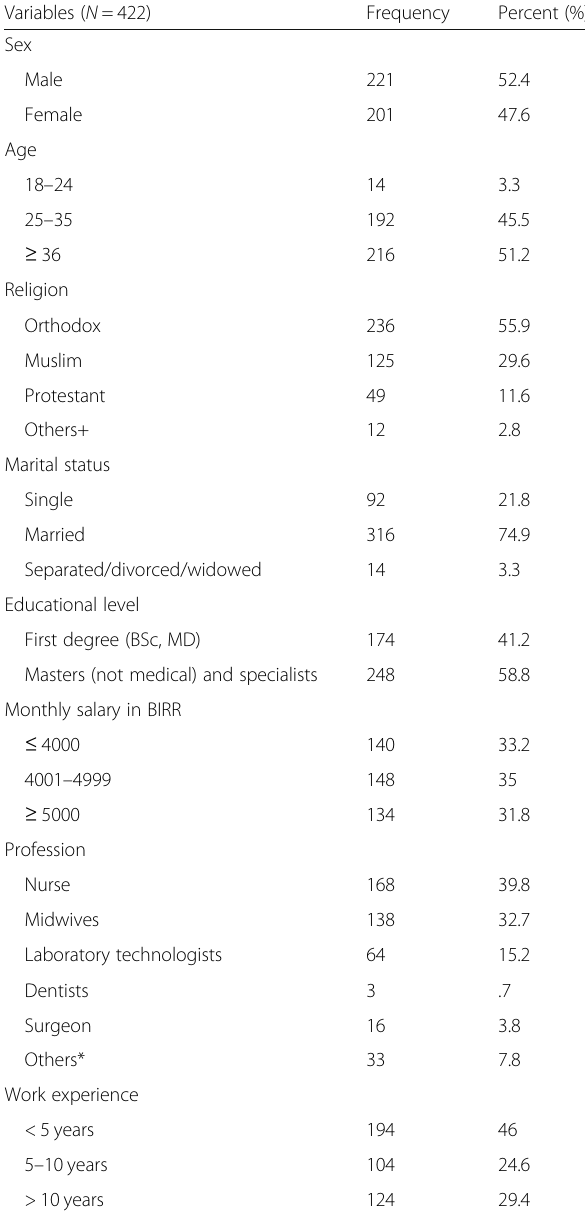
Table 1 Socio-demographic characteristics of HCWs in Gondar town, Ethiopia,